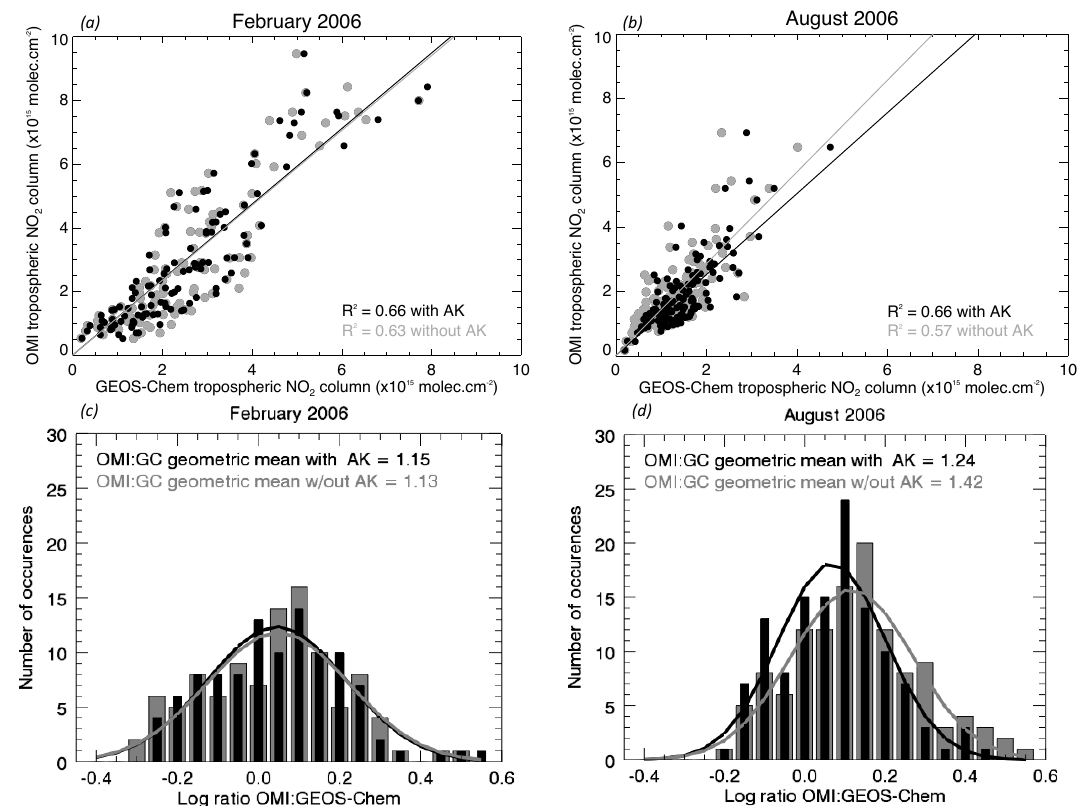
Figure 9. Comparison between monthly average OMI and GEOS-Chem tropospheric NO 2 columns over Europe in February 2006 (left panels) and August 2006 (right panels); (a) scatter diagram of monthly average GEOS-Chem with AK (black circles) and GEOS-Chem without AK (grey circles) vs. OMI tropospheric NO 2 columns for February 2006. The black and grey lines indicate the geometric mean of the OMI : GEOS-Chem ratio; (b) as for (a) but for August 2006; (c) histogram of per-grid cell OMI-to-GEOS-Chem with AK tropospheric NO 2 column ratios (black bars) and OMI-to-GEOS-Chem without AK ratios (grey bars) for February 2006; (d) as (c) but for August 2006. Only grid cells with more than 3 days of better than 40% coverage of clear-sky pixels have been